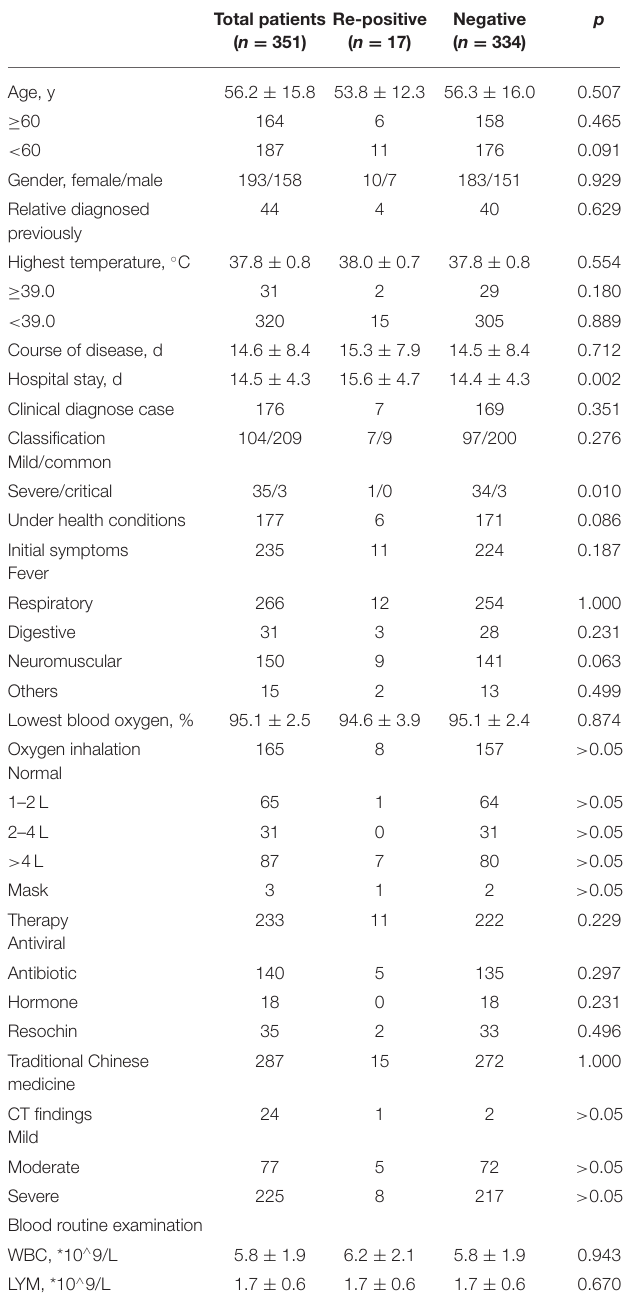
TABLE 3 | Demographic characteristics of 351 discharged patients with